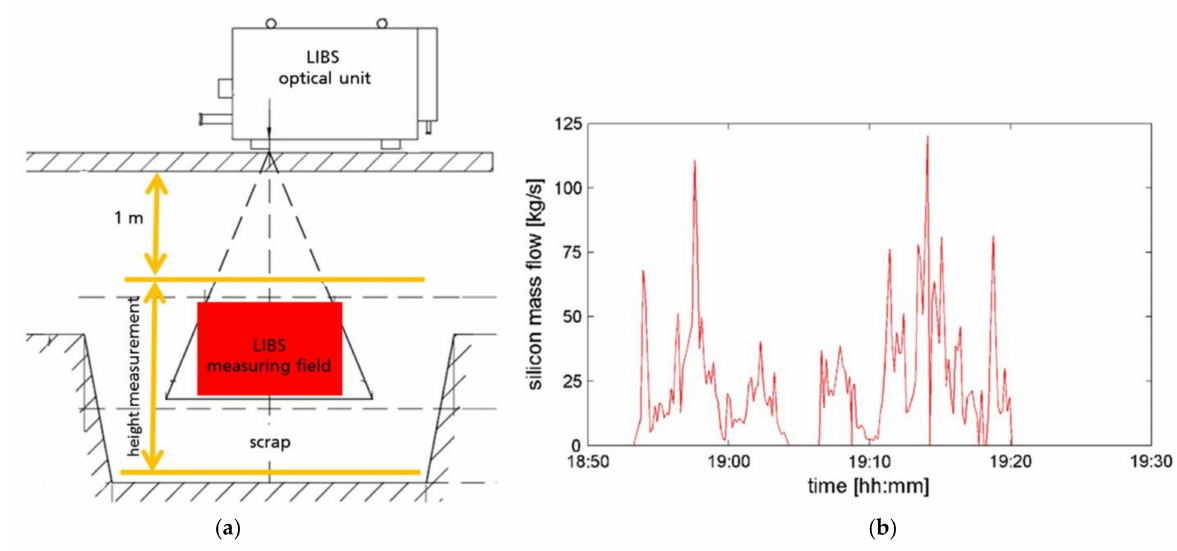
Figure 12. LIBS in-line measurement of steel scrap. ( a ) Schematic of LIBS sensor installed above a conveyor belt in a steel plant. ( b ) Variation of the silicon mass in the scrap on the conveyor as derived from the in-line LIBS measurements. Adapted from [102].